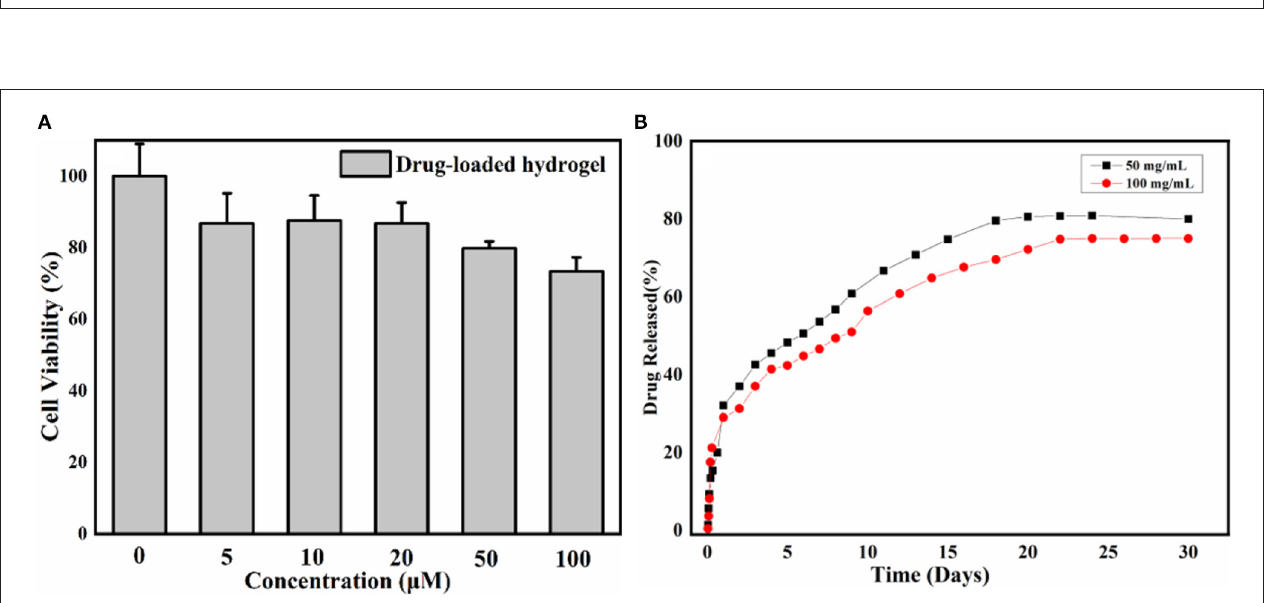
FIGURE 4 | (A) The 24h cell viability test of NAAPD drug-loaded gel in different concentrations and (B) drug release behavior of NMD from the NAAPD drug-loaded gel at 25 ◦ C in water.